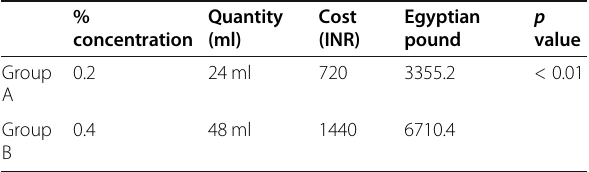
Table 3 Requirement of